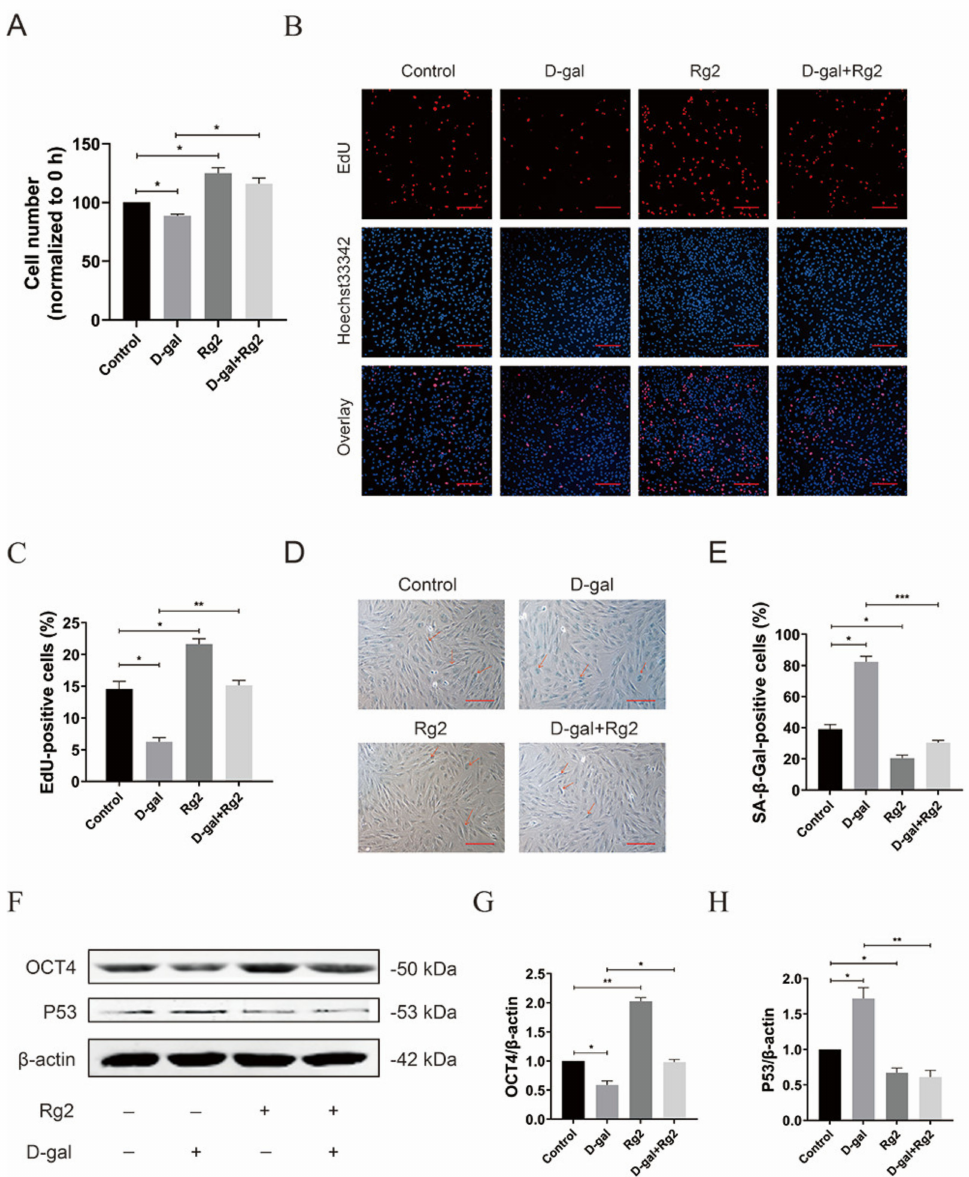
Figure 5. Ginsenoside Rg2 reversed D–gal–induced senescence and maintained stemness in pMSCs. After pre–incubation with 20 g/L of D–gal for 24 h, pMSCs were treated with 100 µ M of Rg2 in the presence/absence of D–gal for another 24 h. ( A ) MTT assay of pMSCs after different treatments. ( B ) EdU staining of pMSCs after different treatments. Scale bar = 200 µ m. ( C ) Quantification of the EdU staining in ( B ). ( D ) SA– β –gal staining of pMSCs after different treatments. SA– β –gal–positive cells were indicated by red arrows. Scale bar = 10 µ m. ( E ) Quantification of the SA– β –gal staining in ( D ). ( F ) Western blot analysis with anti– OCT4 and anti–P53 antibodies in pMSCs after different treatments. ( G ) Quantification of OCT4 expression levels in ( F ). ( H ) Quantification of P53 expression levels in ( F ). * p < 0.05, ** p < 0.01, and *** p < 0.001; n =